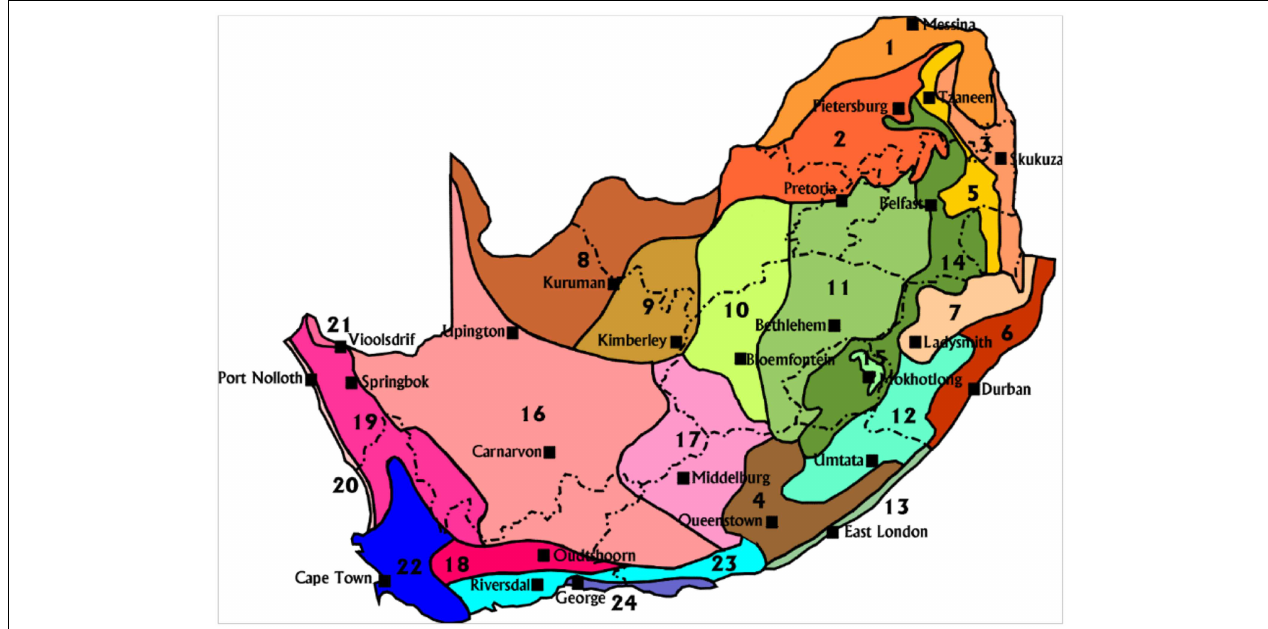
FIGURE 1 | The Kruger climate regions of South Africa after (Kruger,